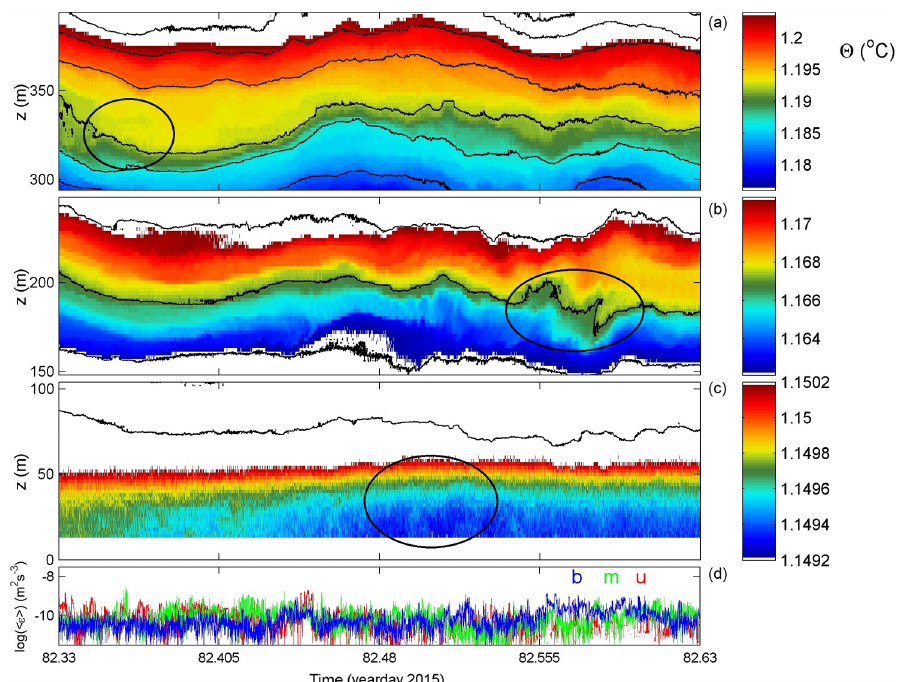
Figure 4. Magnifications of Fig. 3a using different colour ranges but maintaining the 5mK distance between isotherms. (a) Upper 100m of the temperature sensor range (T range). (b) Approximately the middle 100m of the T range. (c) Bottom 100m of the T range; note the entire colour range extending over 1mK only. (d) Time series of the logarithm of vertical mean turbulence dissipation rates from Fig. 3d for panels (a) , (b) and (c) labelled u , m and b , respectively.